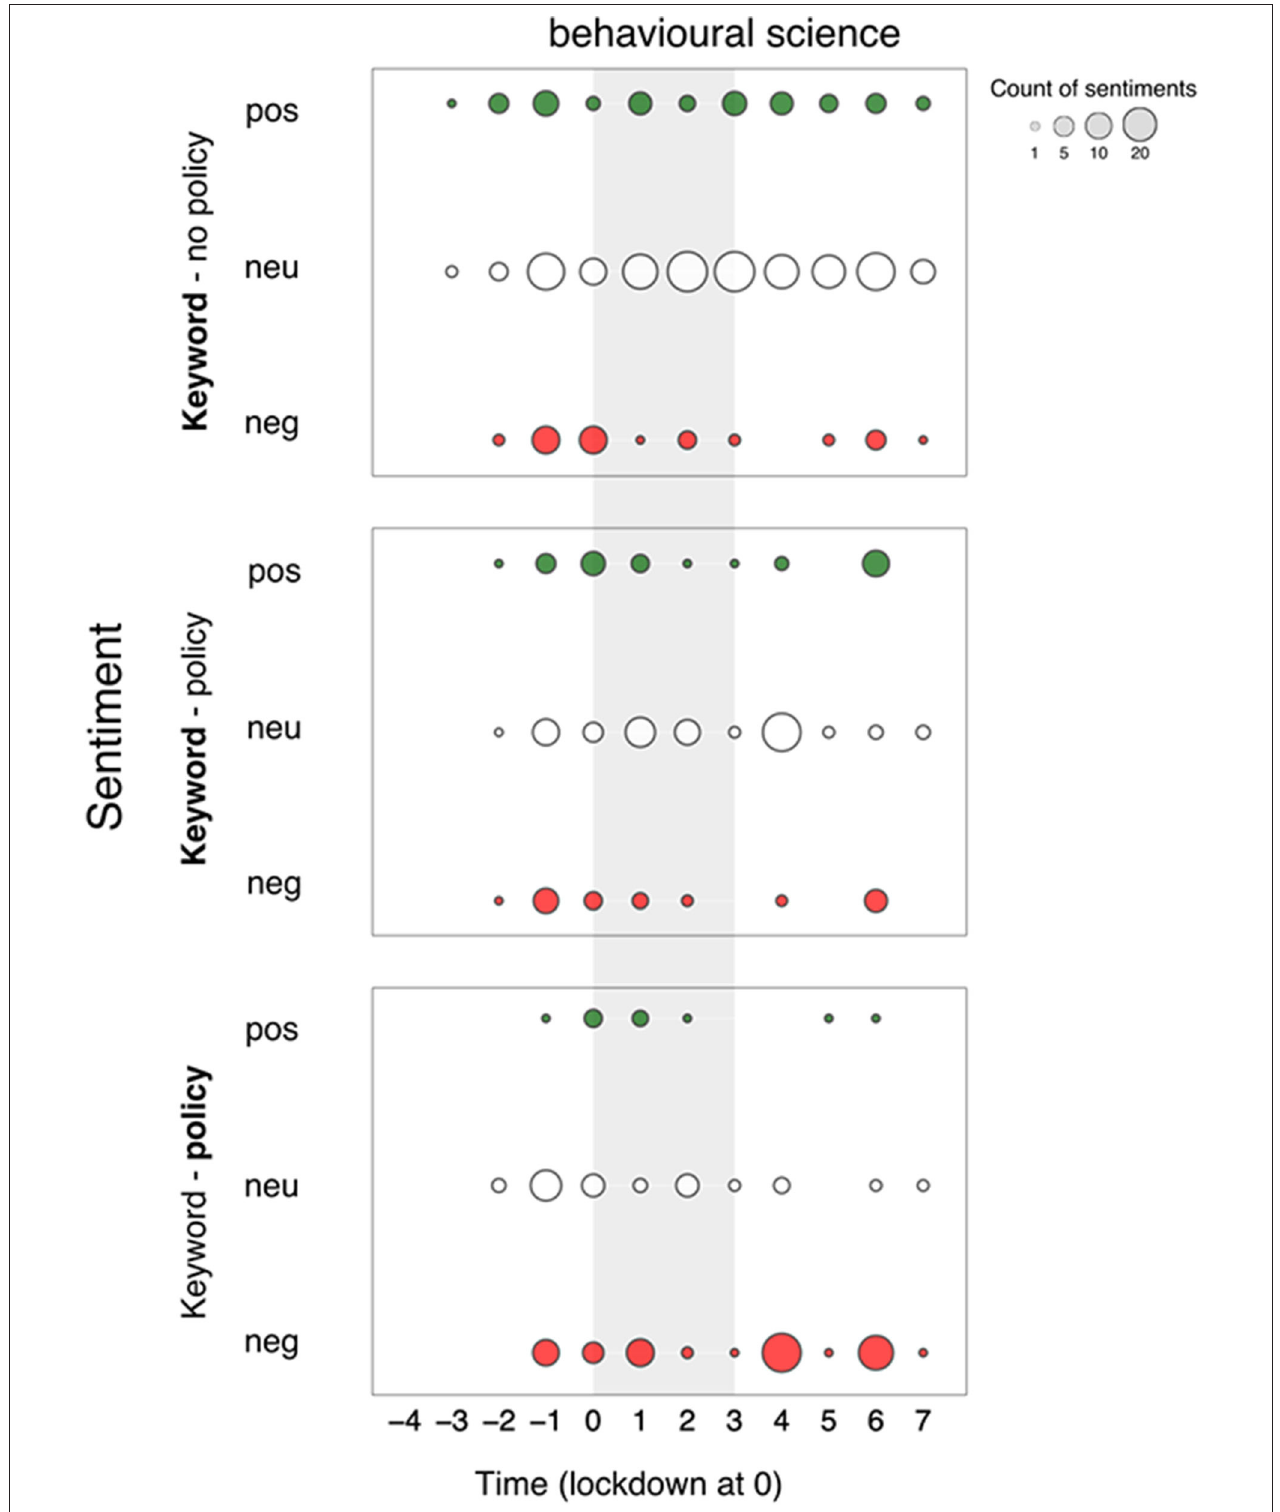
FIGURE 5 | Sentiment toward “ Behavioural Science ” separated by sentences that do not (top) and do refer to national policy application (middle), and sentiment toward policy contexts of keywords (bottom) over the 12 two-week time period surrounding the first British national lockdown of 2020 from newspaper articles. Sentiments are represented in counts of positive ( + 1 or + 2), neutral (0), and negative ( − 2 or − 1) bubbles over time, in green, white and red respectively. The area of the bubbles is proportional to the count of sentiments toward the keyword. Reference category in bold.